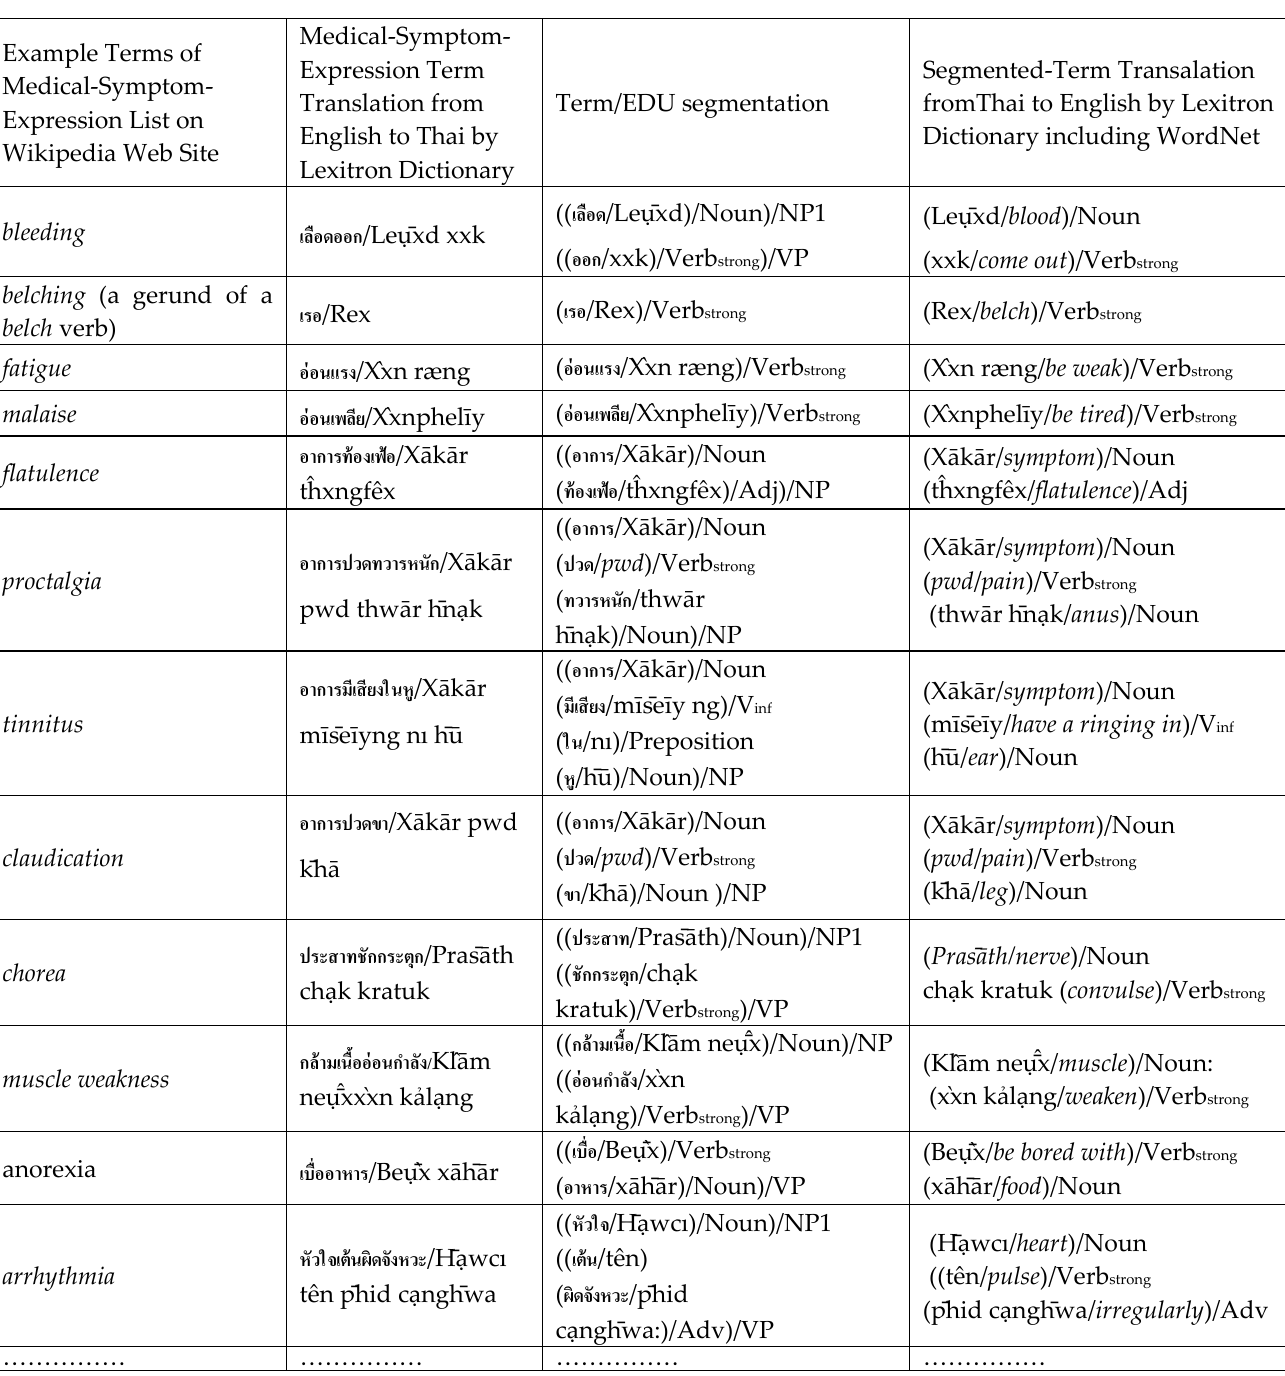
Table 1. Example terms of the medical‑symptom‑expression list used for collecting the element concepts in Verb strong , Verb weak , Noun, Adj, and Adv sets of the segmented‑term translation.